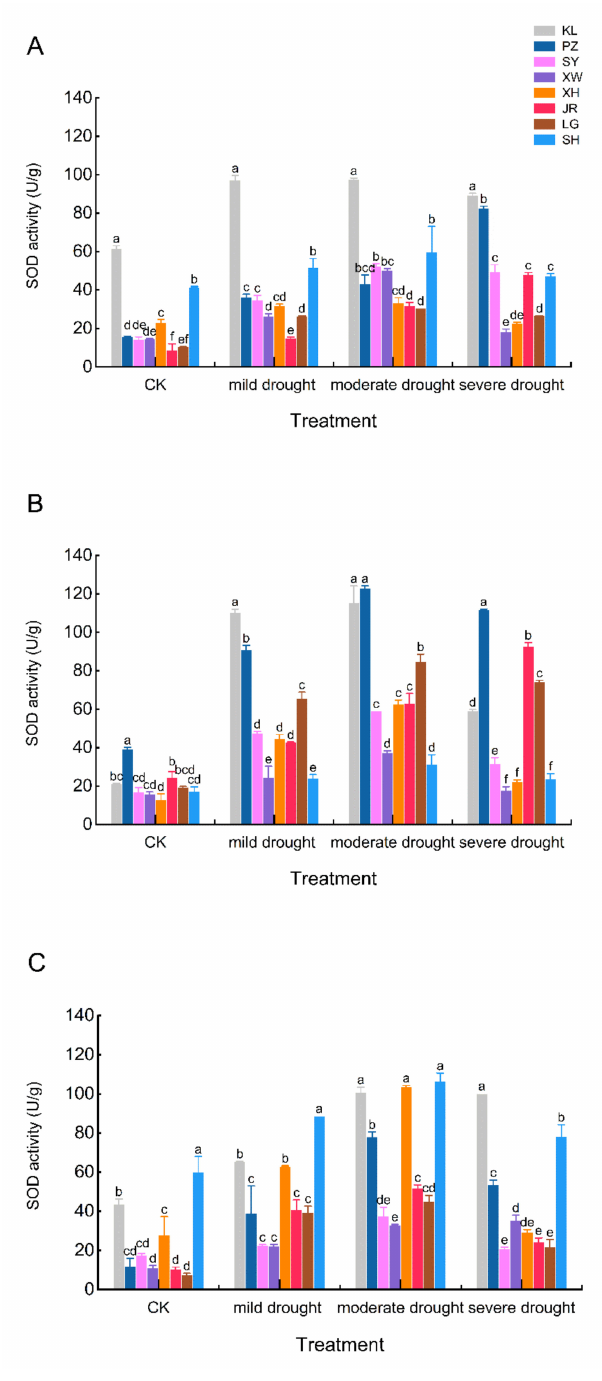
Figure 9. The superoxide dismutase activity of Melia azedarach among different provenances: ( A ): early stage, ( B ): middle stage, and ( C ): late stage. Note: The error line in the figure is the mean ± standard error, and different lowercase letters in the same treatment indicate significant differences at the 0.05